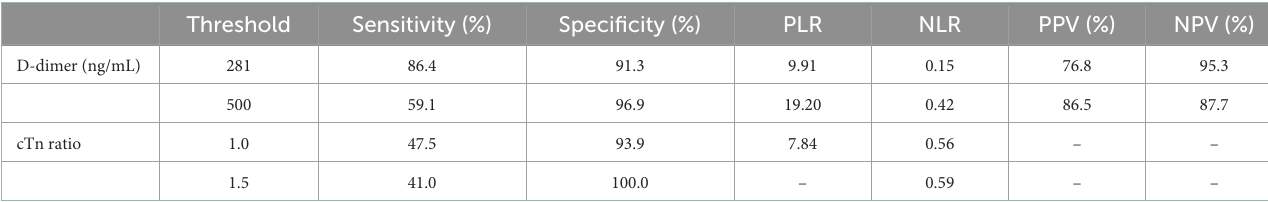
TABLE 3 Diagnostic performance of D-dimer for AAS and cTn ratio for NSTEMI with chest pain onset < 2h.